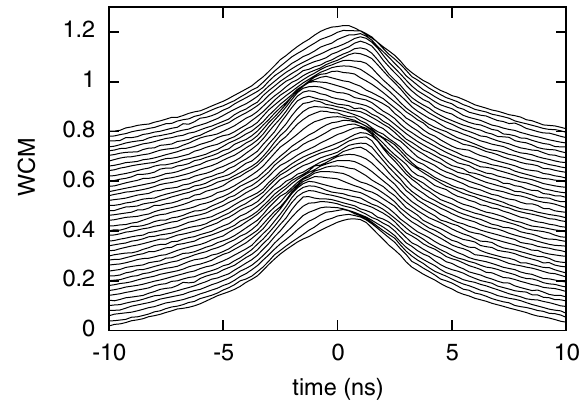
FIG. 4. Wall current monitor data for a bunch at the begin- ning of flattop.